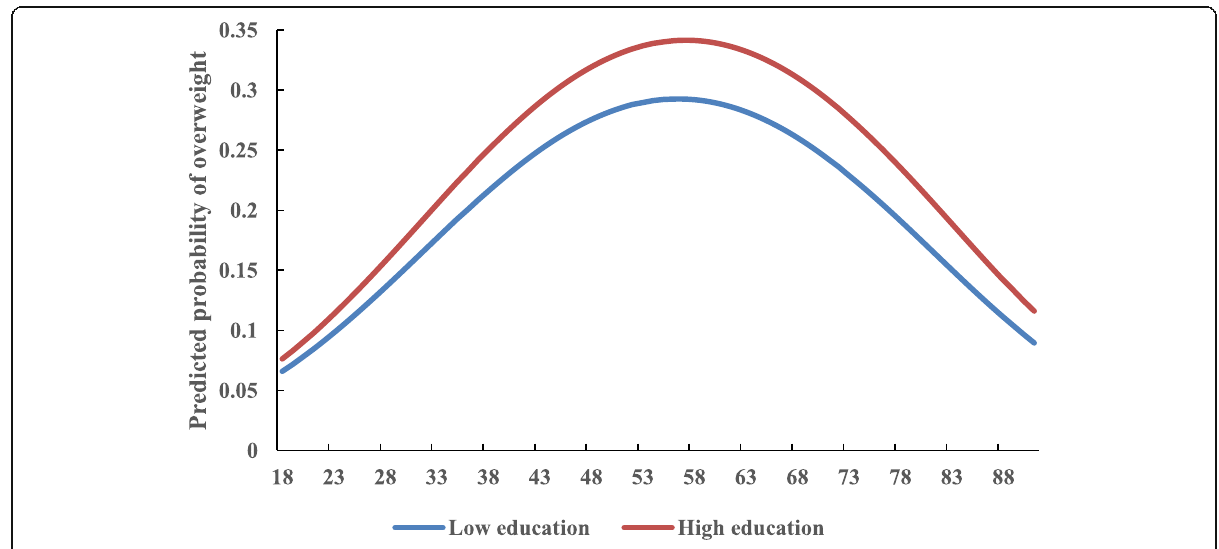
Fig. 3 Education-specific age effects on overweight, adjusted for period and cohort effects and all